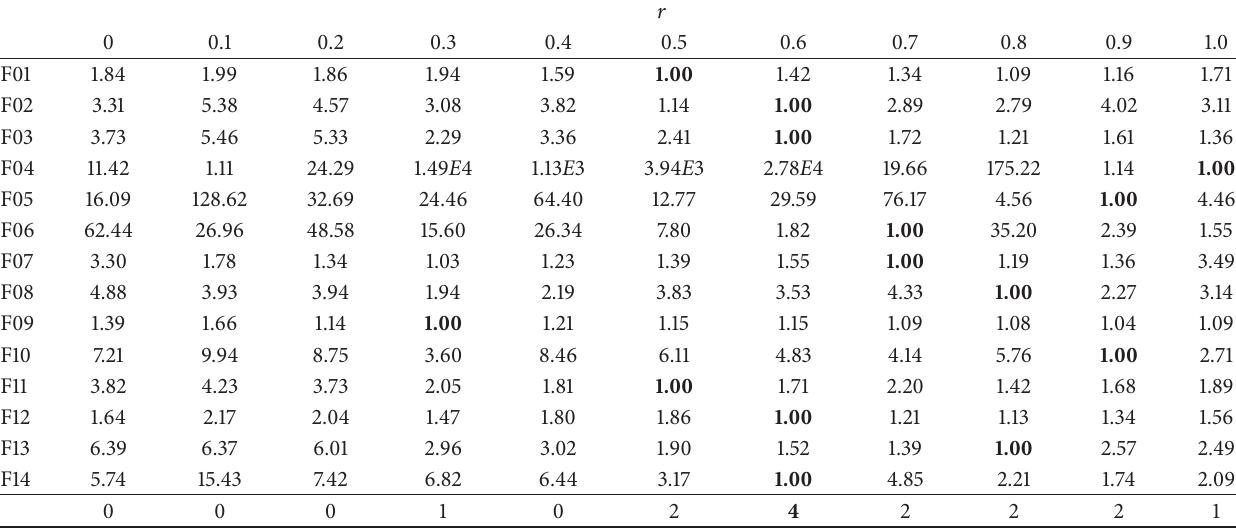
Table 8: Mean normalized optimization results in fourteen benchmark functions with different 𝑟 . The numbers shown are the minimum objective function values found by HS/BA algorithm, averaged over 100 Monte Carlo simulations.